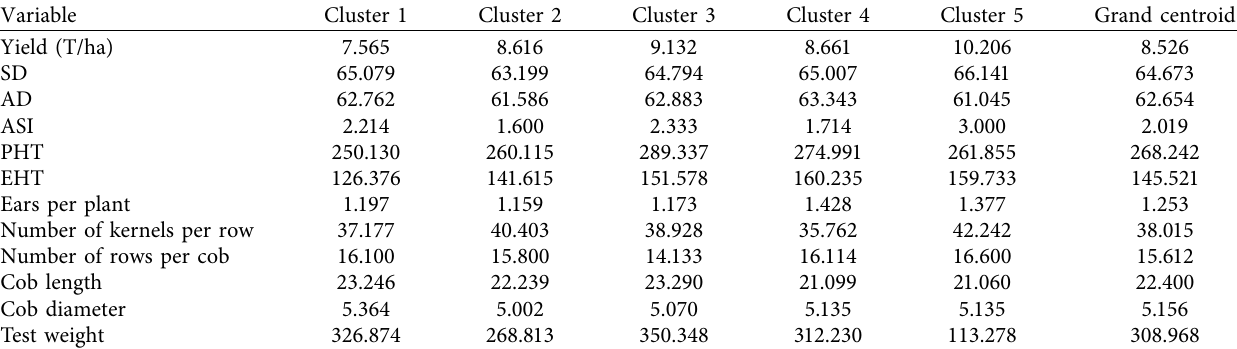
Table 9: Distance between clusters of yield traits.